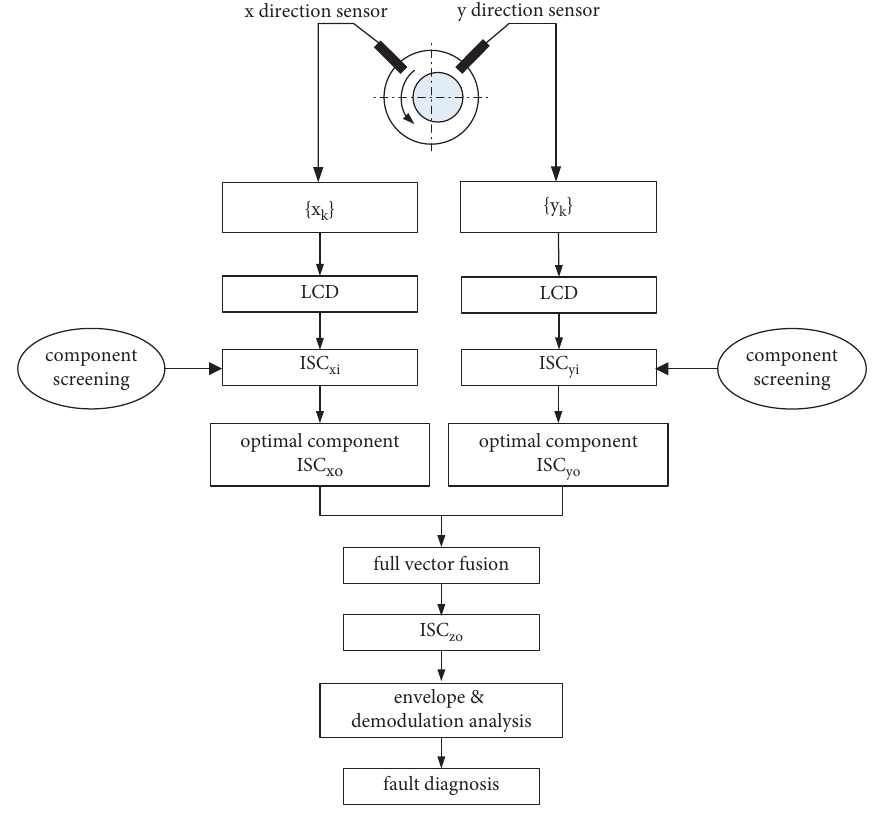
Figure 2: Flowchart of vector LCD.